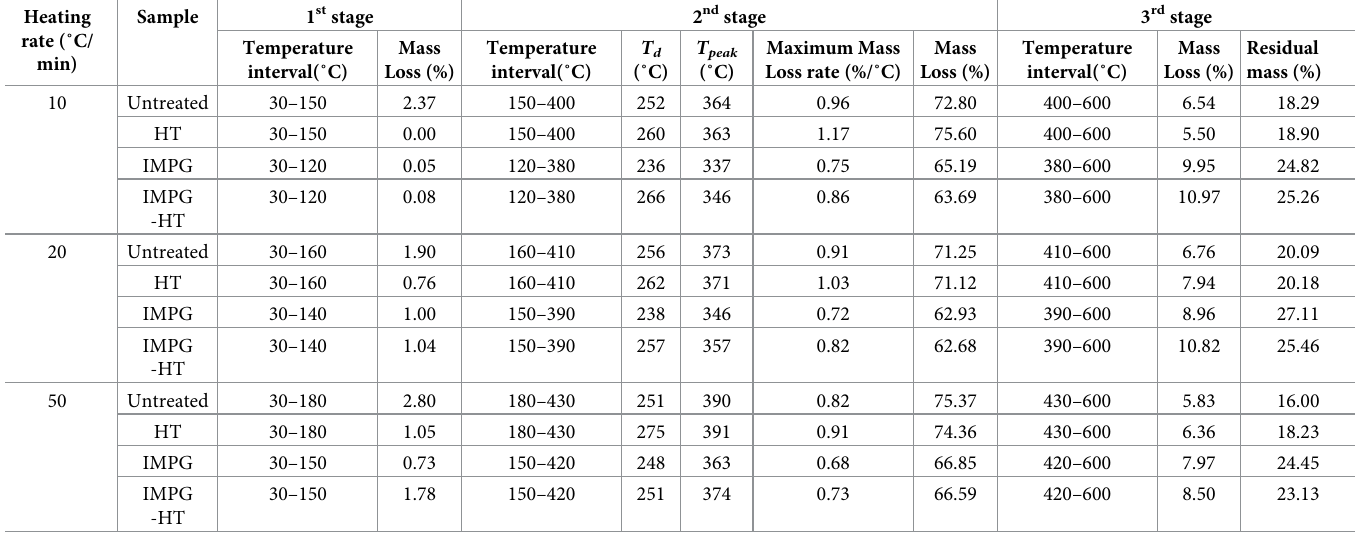
Table 3. Characteristic parameters of TG and DTG curves for samples at different heating rates.